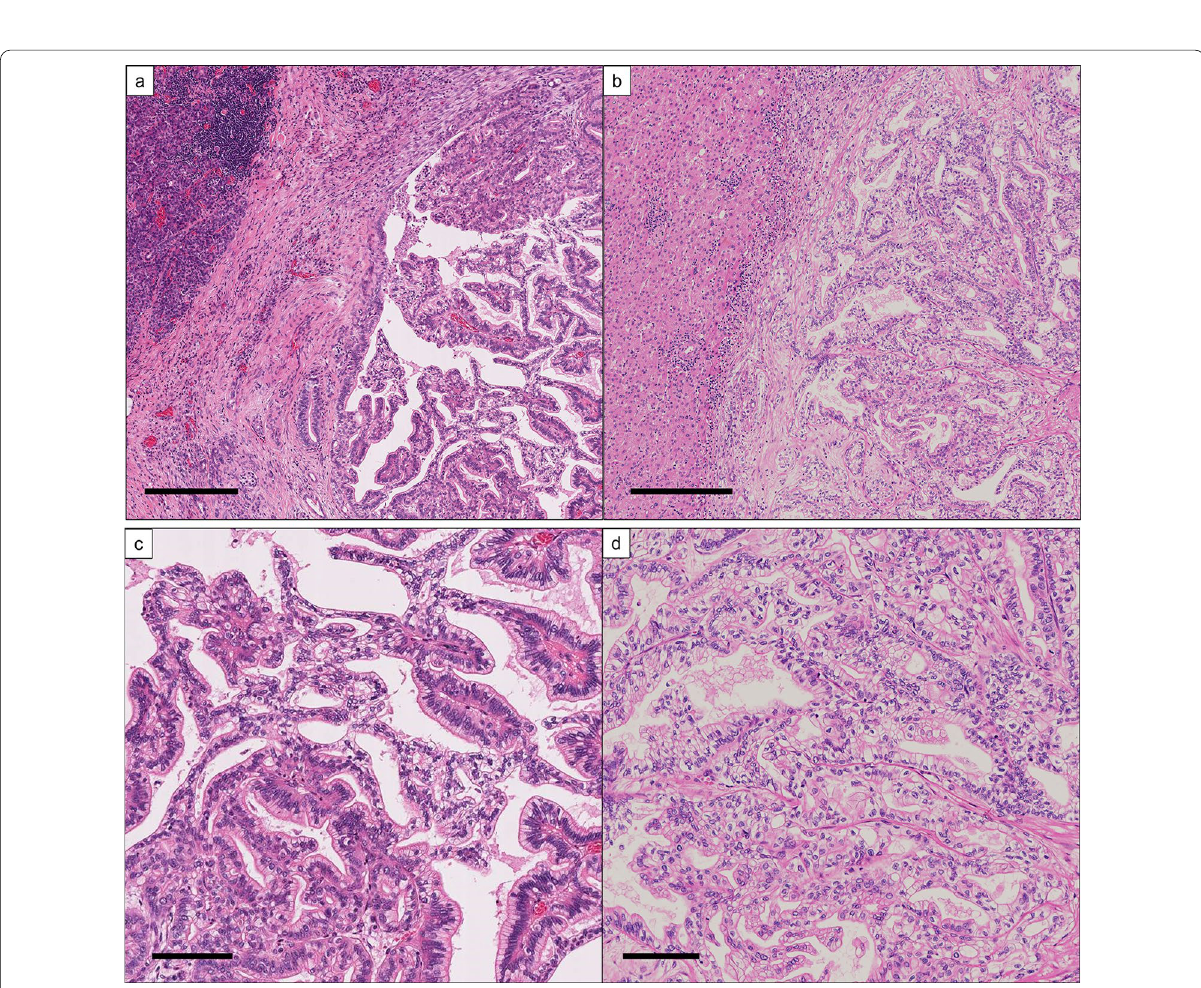
Fig. 3 Histologic appearances of a the primary pancreatic cancer and b its liver metastasis. Enlarged views are shown in c and d , respectively. The cancer cells have round nuclei with clear cytoplasm and show a tubulopapillary architecture. Scale bars, 300 µm (low-power field), 100 µm (high-power